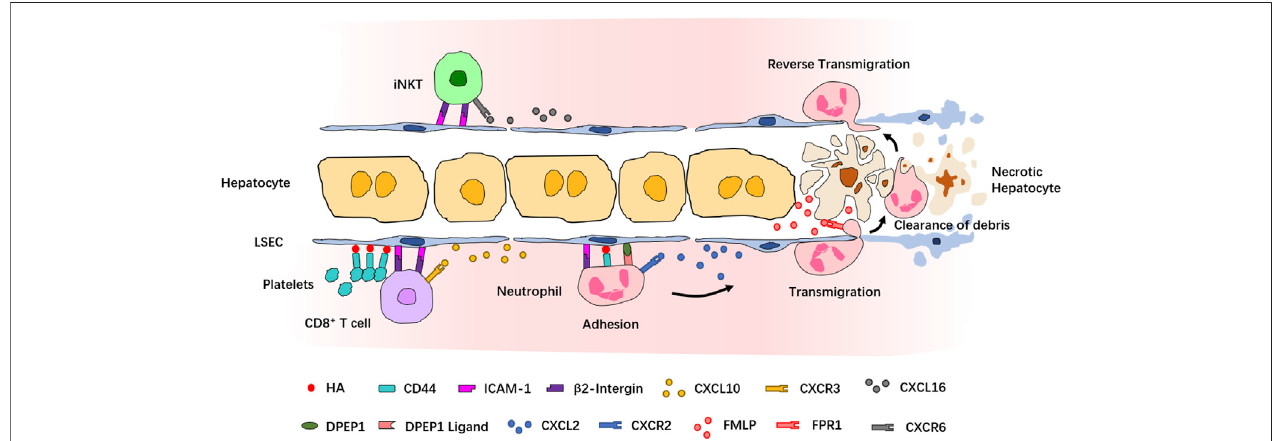
FIGURE 2 | Recruitment cascade of leukocytes during in fl ammation revealed by IVM. Neutrophils are the fi rst population recruited into the site of in fl ammation. In sterile injury-induced liver in fl ammatory response, neutrophils are attracted by the chemokine CXCL2 and adhere to LSECs via a series of adhesion molecules. Formyl- peptidereleasedbynecrotichepatocytesmediatesneutrophiltransmigrationtoreachthenecroticcellsandclearthedebrisofdeadcells.Aftertheclearance,neutrophils returntothesinusoids via reverse transmigration. CD8 + Tcells andiNKT cellsareattracted by,respectively, CXCL10 andCXCL16 and adhere toLSECs via similar mechanisms. Platelets also contribute to the retention of CD8 + T